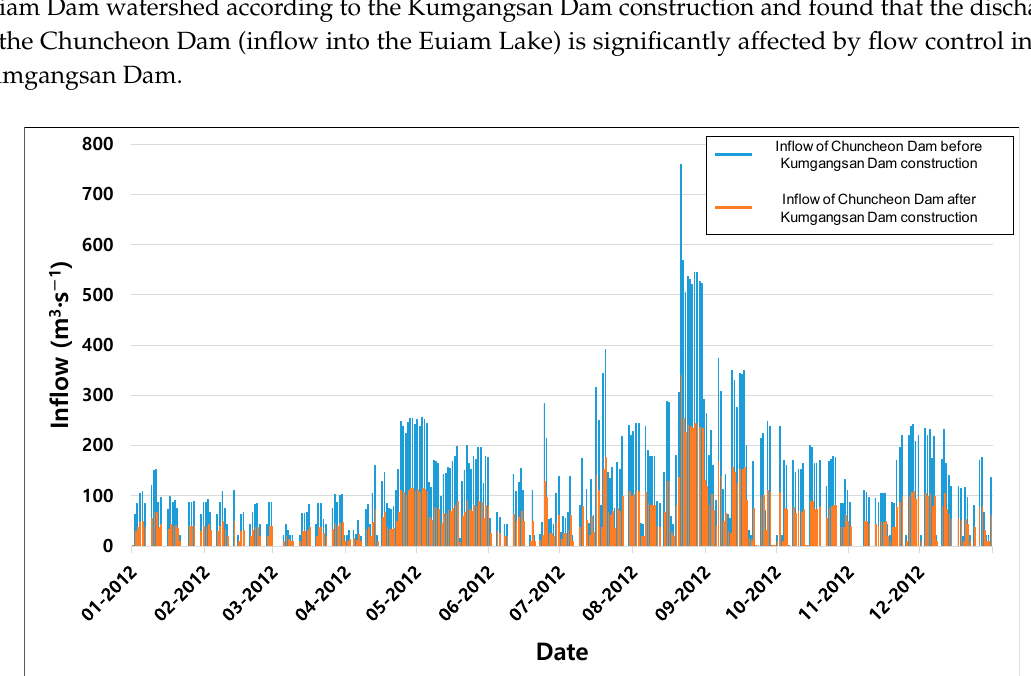
Table 5. Water budget analysis result for each dam. Unit: Mm 3 y − 1 .